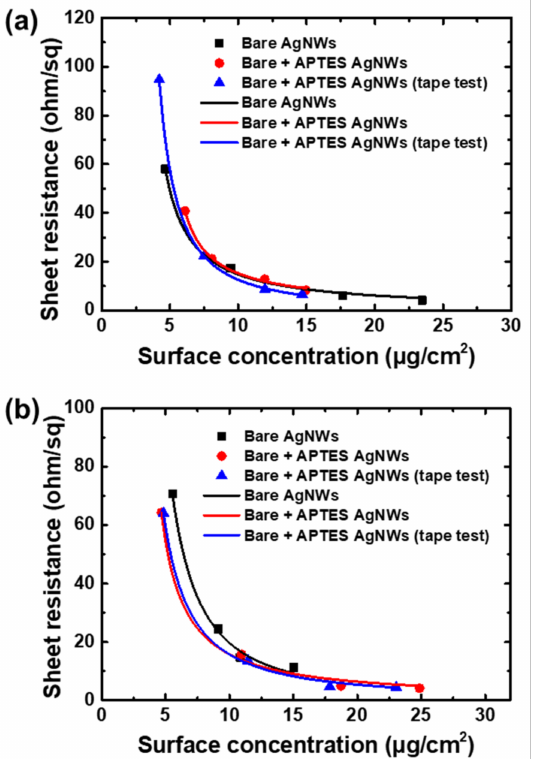
Figure 8. Sheet resistance of the AgNWs networked thin films as a function of the AgNWs surface concentration ( a ) before annealing and ( b ) after annealing. The solid lines are a fit to the percolation equation (Equation